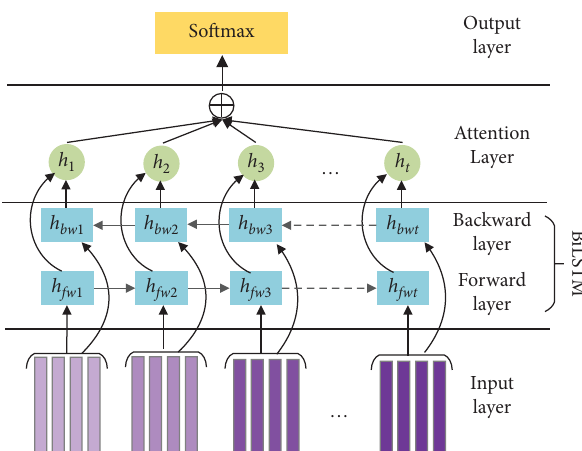
Figure 2: AT-Bi-LSTM structure: input layer is used to input data; the data fows into the forward and backward layers of the Bi-LSTM to obtain important clues in the data. Te attention layer is used to remove useless information from data and extract key features. Te softmax layer is responsible for outputting pedestrian